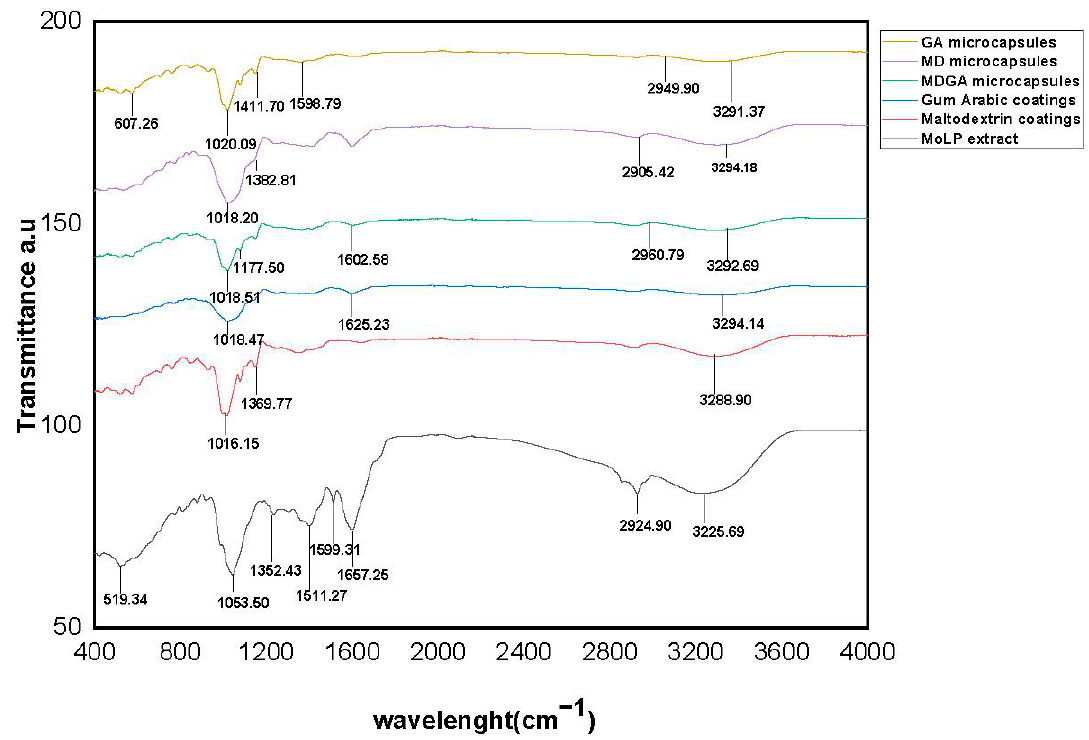
Figure 2. FTIR spectra of maltodextrin, gum arabic, M. oleifera leaf powder extracts, microcapsules of M. oleifera leaf powder with maltodextrin, gum arabic and maltodextrin-gum Arabic mixture.